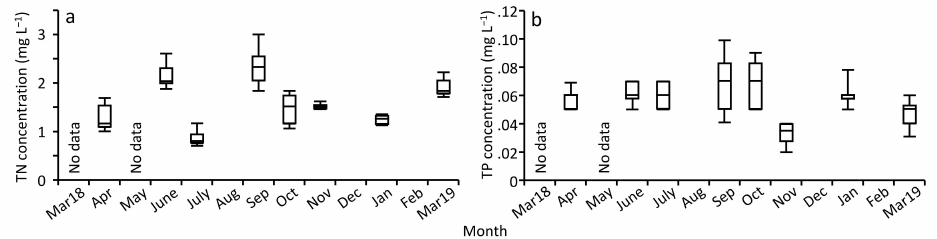
Figure 4. Box plot of total nitrogen ( a ) and total phosphorus ( b ) measured at 6 sites and 2 vertical layers each month in MA. The box plot shows 10, 25, 50, 75, 90 percentiles of data each month. Cyanobacterial bloom was not observed at any sites during the study in MA. The phytoplankton community collected for a single time in May was dominated by green algae and diatom species. Cyanobacteria Microcystis species, which were abundant in the ZS pond, were not found (Table